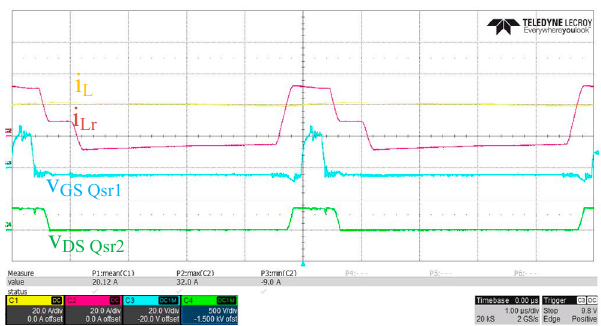
Figure 18. Resonant inductor current and output inductor current waveform, Q sr 1 switch’s v GS signal and Q sr 2 switch’s v DS voltage at V O = 50 V, Io = 20 A (scale i L (Ch1): 20 A/div; i Lr (Ch2): 20 A/div; v GS_Qsr 1 (Ch3): 20 V/div; v DS_Qsr 2 (Ch4): 500 V/div; time: 1 μ s/div).